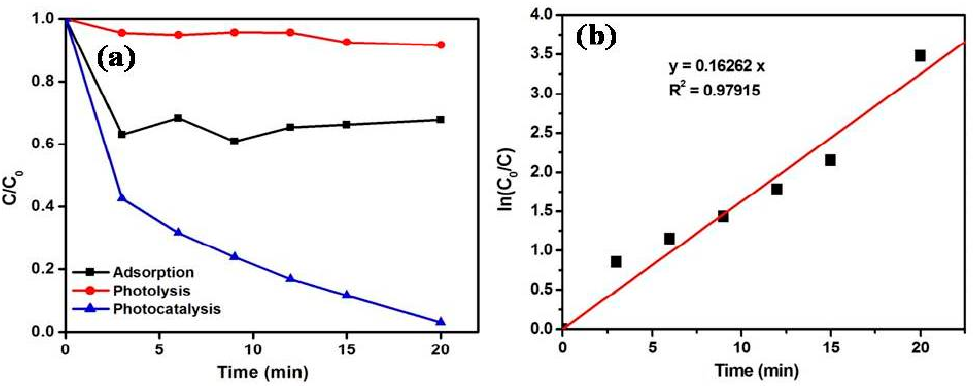
Figure 9. ( a ) Comparison between adsorption, photolysis, and photocatalysis for the removal of MB; ( b ) Kinetic curve for decomposition of MB over the prepared MoS 2 /ZnO heterostructure in the presence of solar light under optimized reaction parameters.